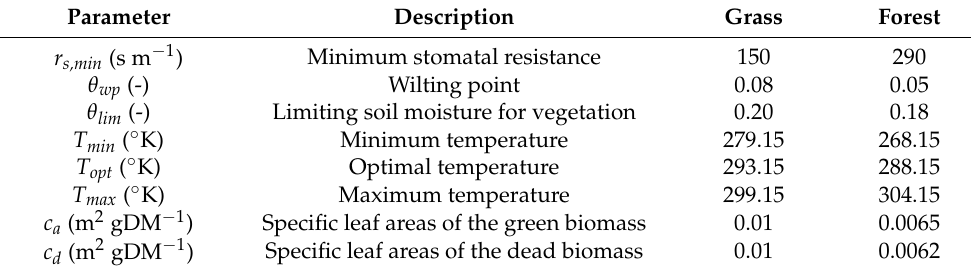
Table 1. Model parameters of the vegetation